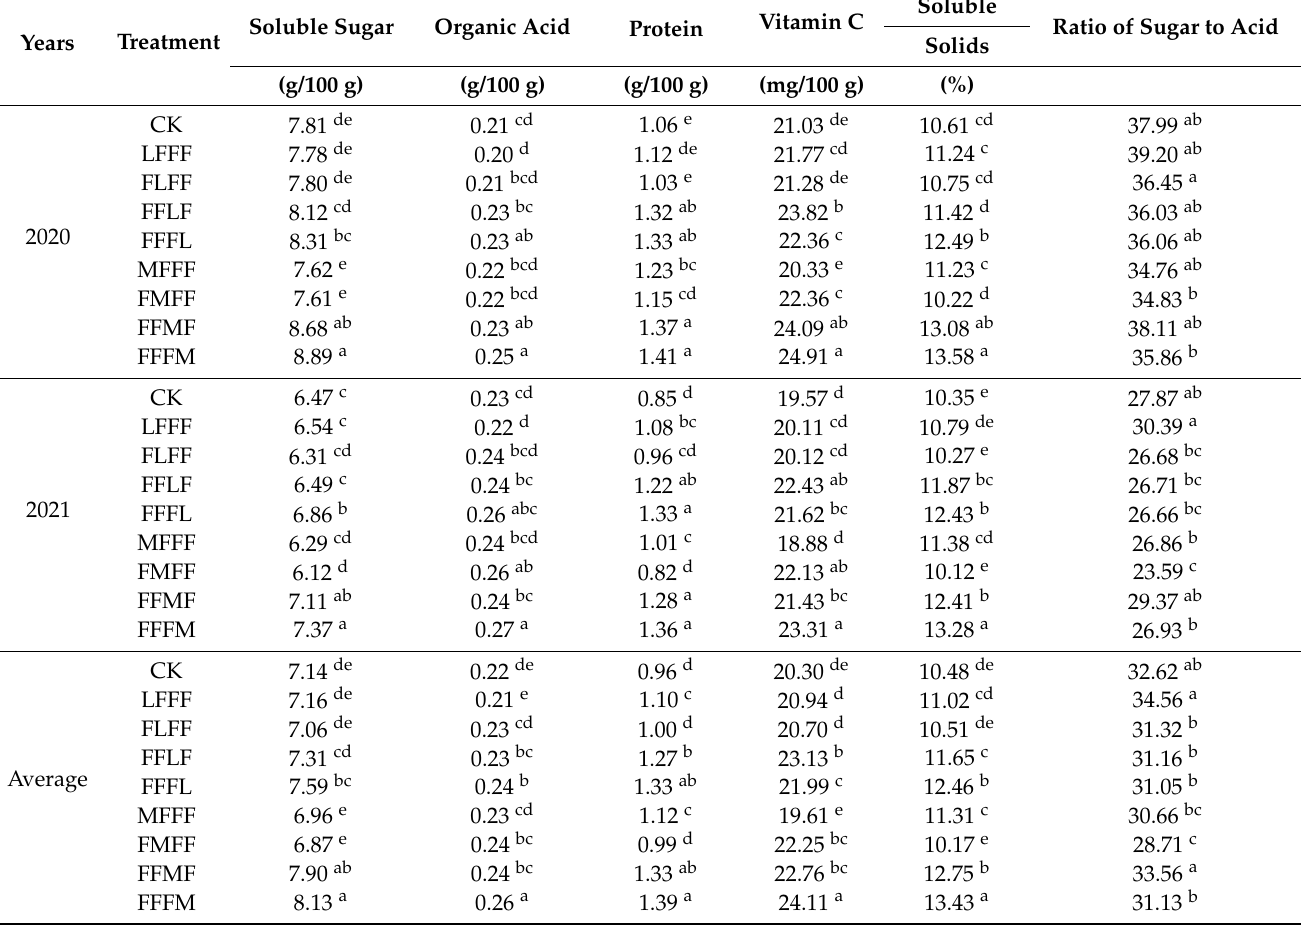
Table 3. Effects of different deficit irrigation treatments on qualities of